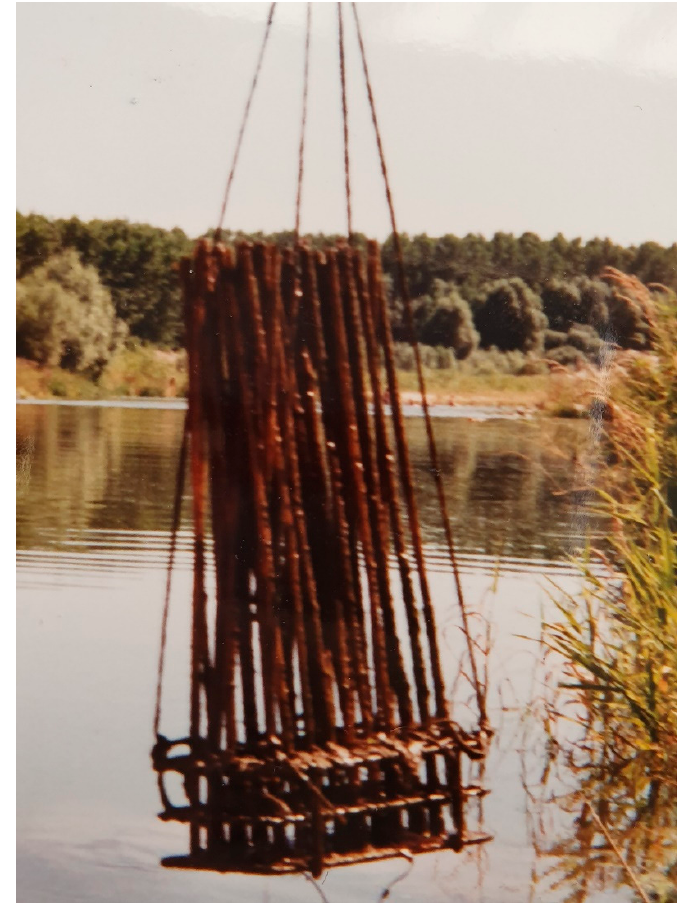
Figure A1. Discharge rates in the Cikola tributary system from 1995 to present.